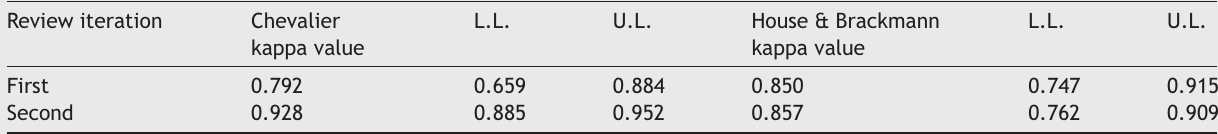
Evaluation of intra-rater interpretation of the degree of facial paralysis impairment in both moments of evaluation. Review iteration Chevalier kappa